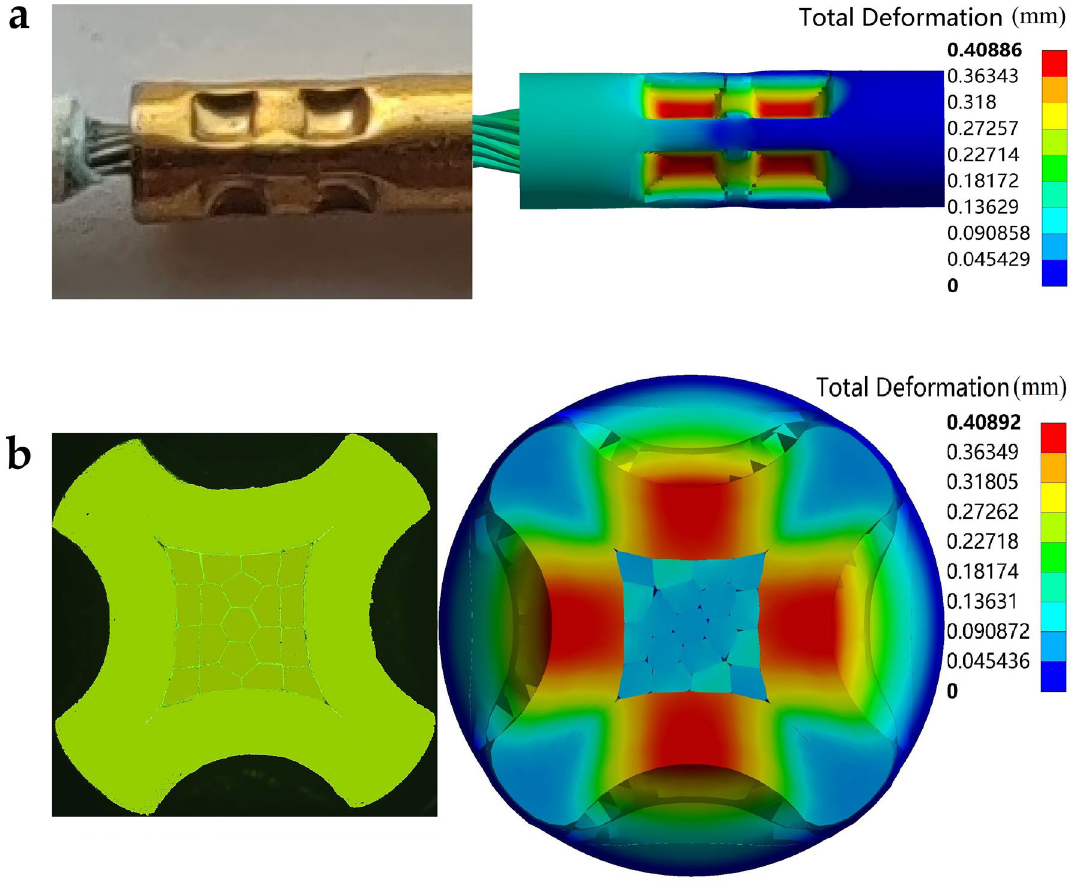
Figure 9. Comparison of crimping assembly geometries in experiment and